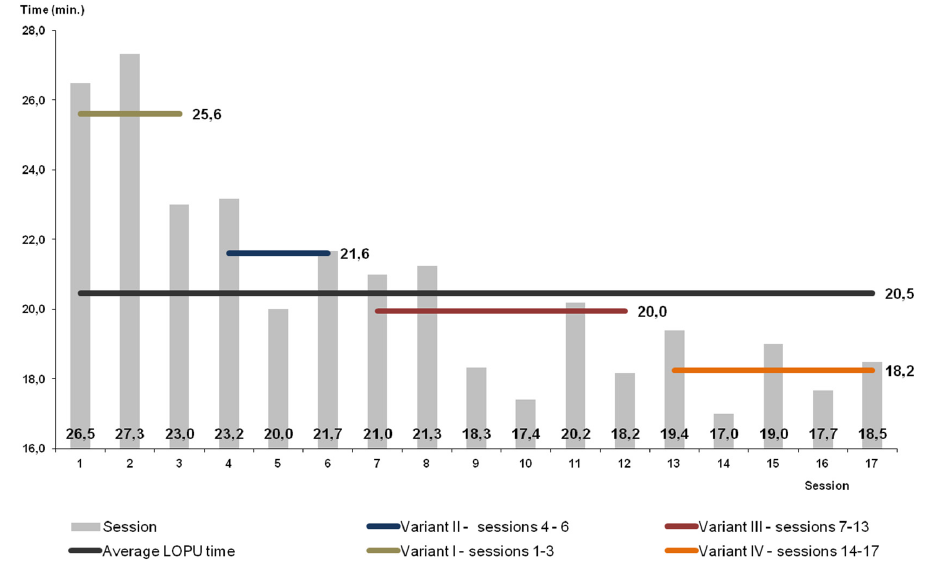
Figure 6. Timing of the L-OPU procedure in goats. Animals 2020 , 10 , x FOR PEER REVIEW